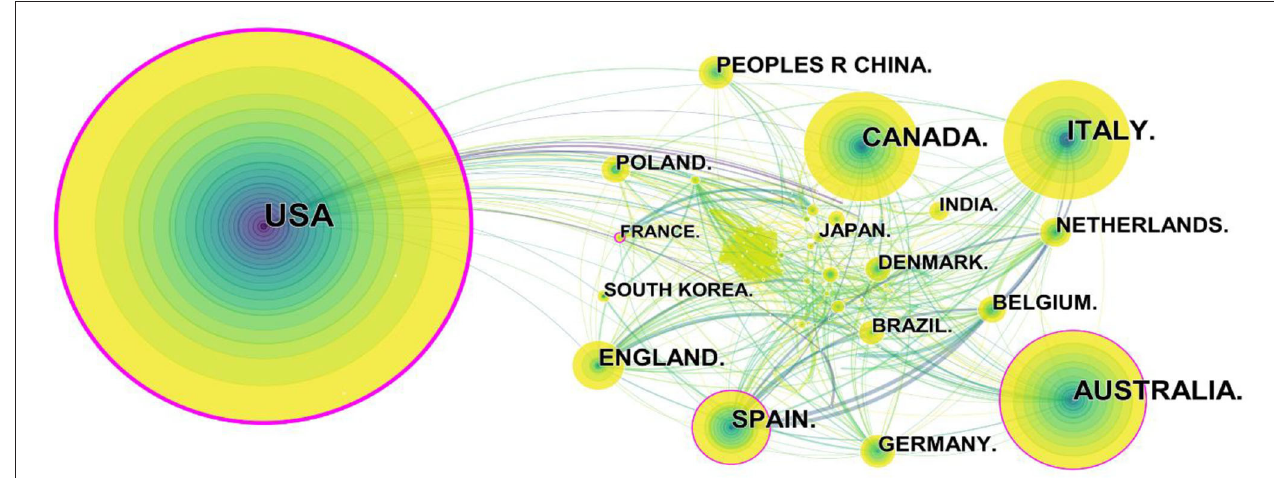
FIGURE 3 | Map of countries researching telerehabilitation from 2000 to 2021.